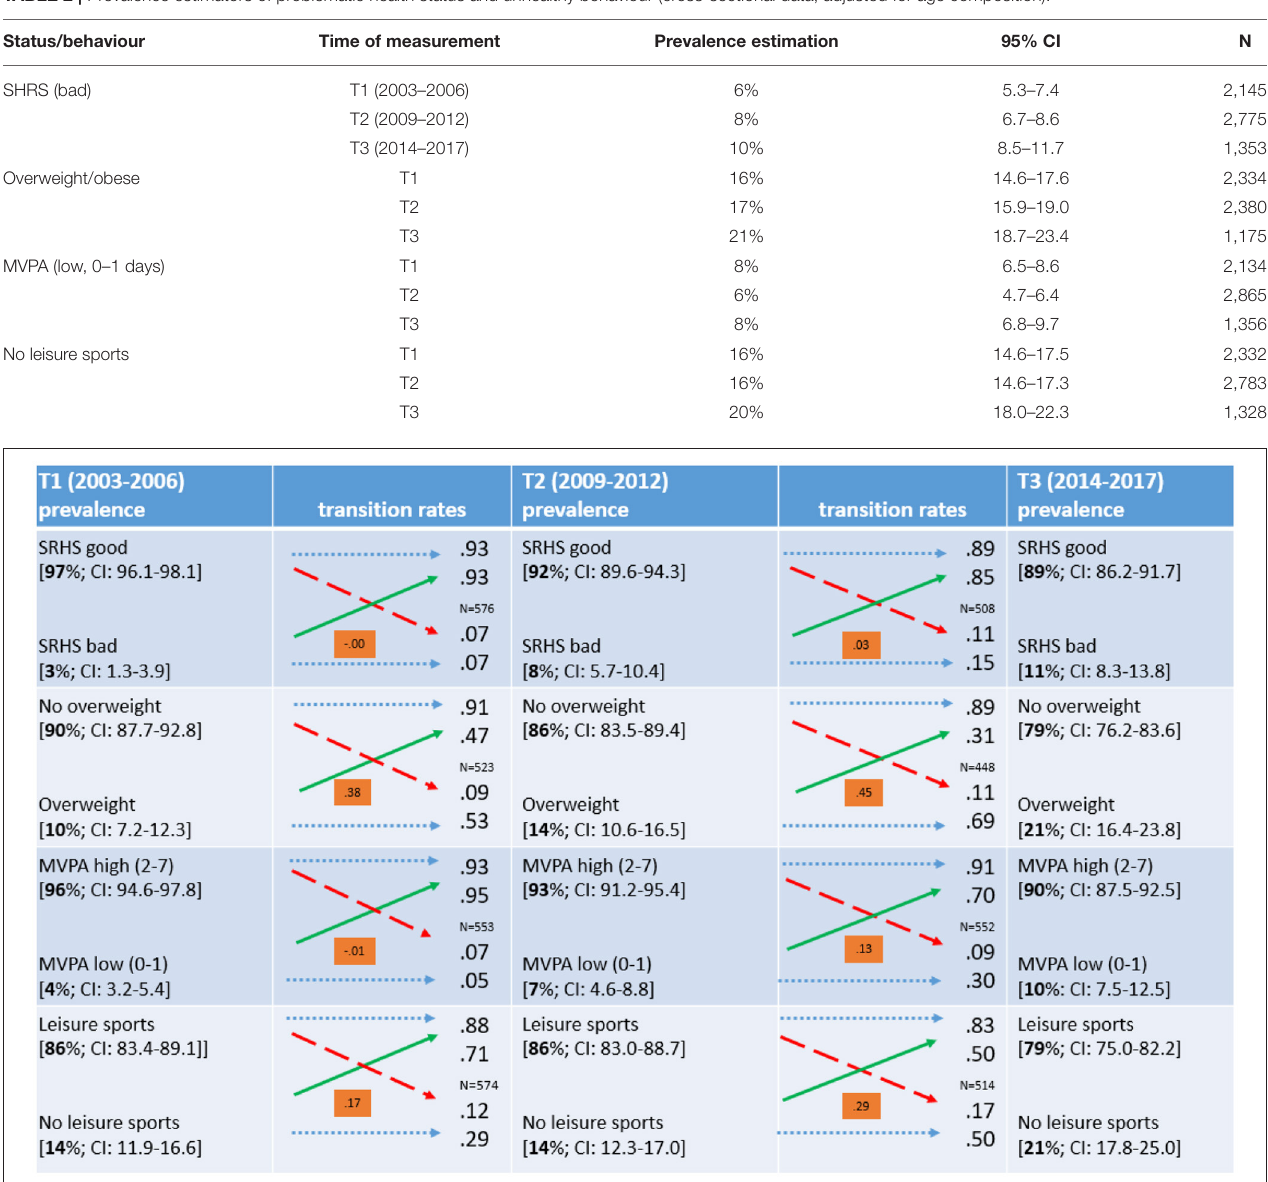
FIGURE 1 | Transitions of the dependent variables between the surveys. MoMo/KiGGS; sample restricted to respondents who participated in all three waves within age of 6–17 years (when having been surveyed); number of cases also vary due to missing values; for prevalence rates 95%- confidence intervals are reported; dotted blue arrows represent stability across times of measurements; dashed red arrows represent transitions from the normal to the problematic group (worsening); solid green arrows represent transitions from the problematic to the normal group (improving); for each transition table Kendall’s Tau b reported as an indicator of strength of the association (range of value from − 1 to + 1). An association indicates whether the distribution of participants into dichotomous categories at an earlier time of measurement has a notable predictive power for the distribution at the subsequent